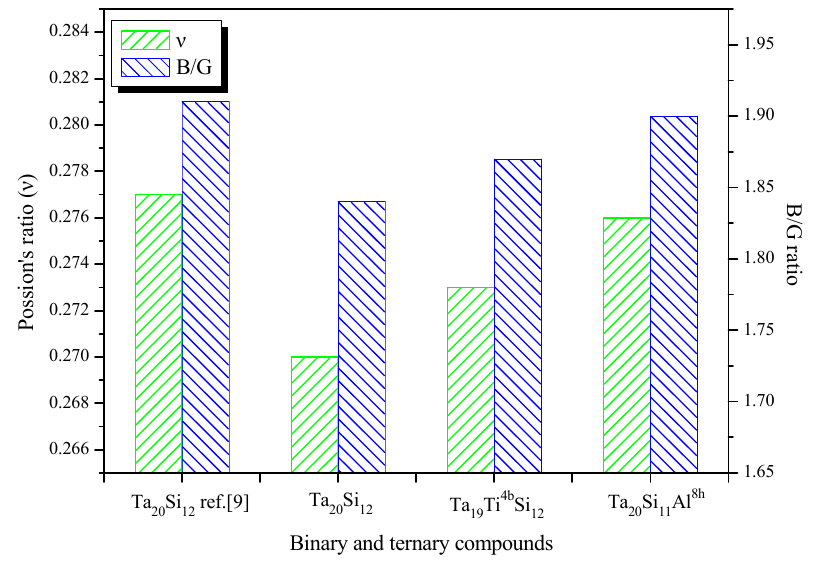
Figure 4. The Poisson’s ratio, ν , and the Pugh modulus ratio, B / G , for Ta 20 Si 12 , Ta 20 Si 11 Al 8h and Ta 19 Si 12 Ti 4b . Theoretical values reported in the literature [8] are shown in the figure for comparison.